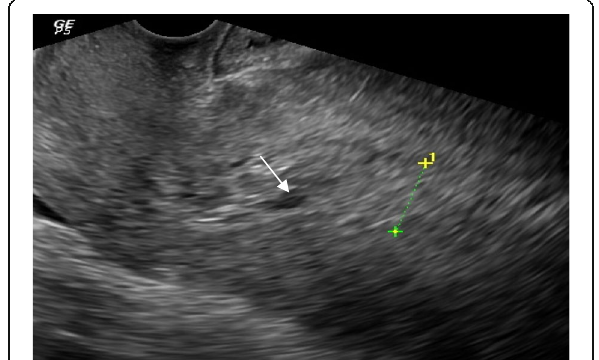
Fig. 6 Sagittal view by TVUS showing thickened echogenic endometrium and heterogeneous echo pattern measuring about 14.7 mm in maximal anteroposterior diameter, showing variable sized cystic hypoechoic areas (white arrow) and preserved subendometrial halo. Histopathology result of the endometrial biopsy was consistent with endometrial cystic atrophy